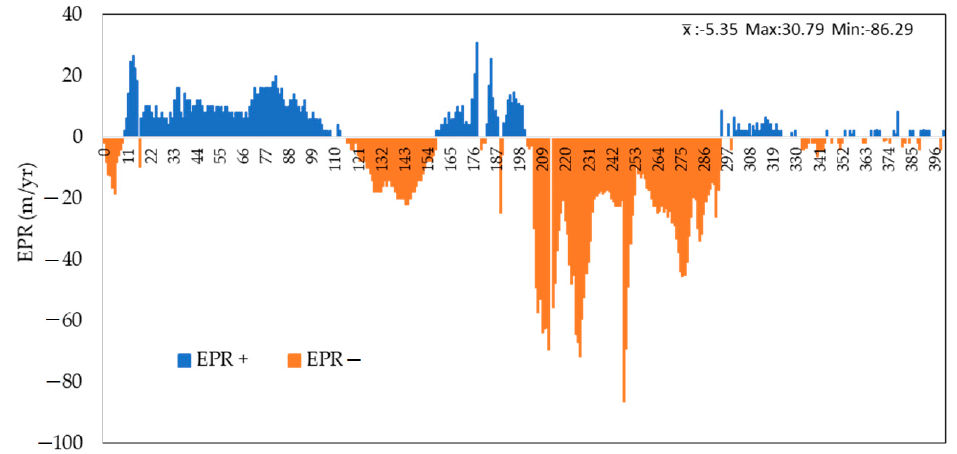
Figure 11. Calculation curve of Subarnarekha’s estuarine section for shoreline change of Digha Coast. Axis x shows the transect number. The numbering of the transects increases towards the East.